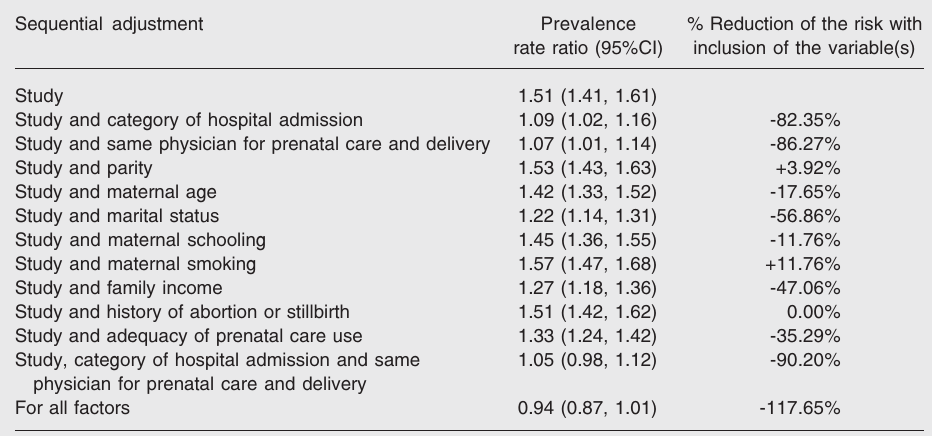
Table 3. Multivariable analysis of risk factors for cesarean section in a joint sequential model (Ribeirão Preto, 1994 and São Luís,